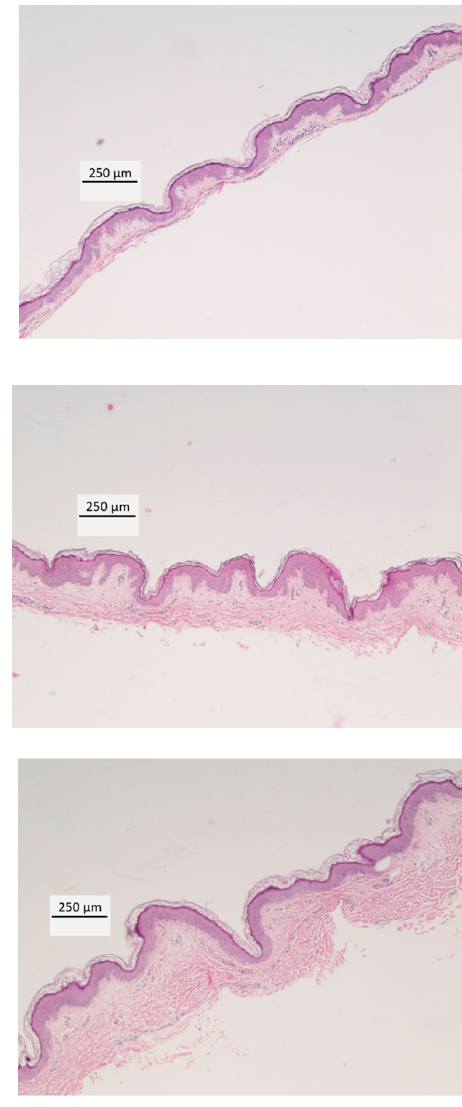
Figure 10. First column, autofluorescence and fluorescence spectra measured with the SpectroLive device and its optical probe put in gentle contact with an ex vivo skin sample put on top of a fluorescent gel for the 405 ‐ nm excitation wavelength at four source ‐ to ‐ detector separations (D1: blue, D2: red, D3: yellow and, D4: purple) for three ex vivo human skin samples of different thicknesses (first line: 155, second line: 305 and, third line: 519 μ m). Second column: corresponding pictures of hematoxylin and eosin (H&E) stained ‐ histological slides of human skin samples. Scale bar = 250 μ m.